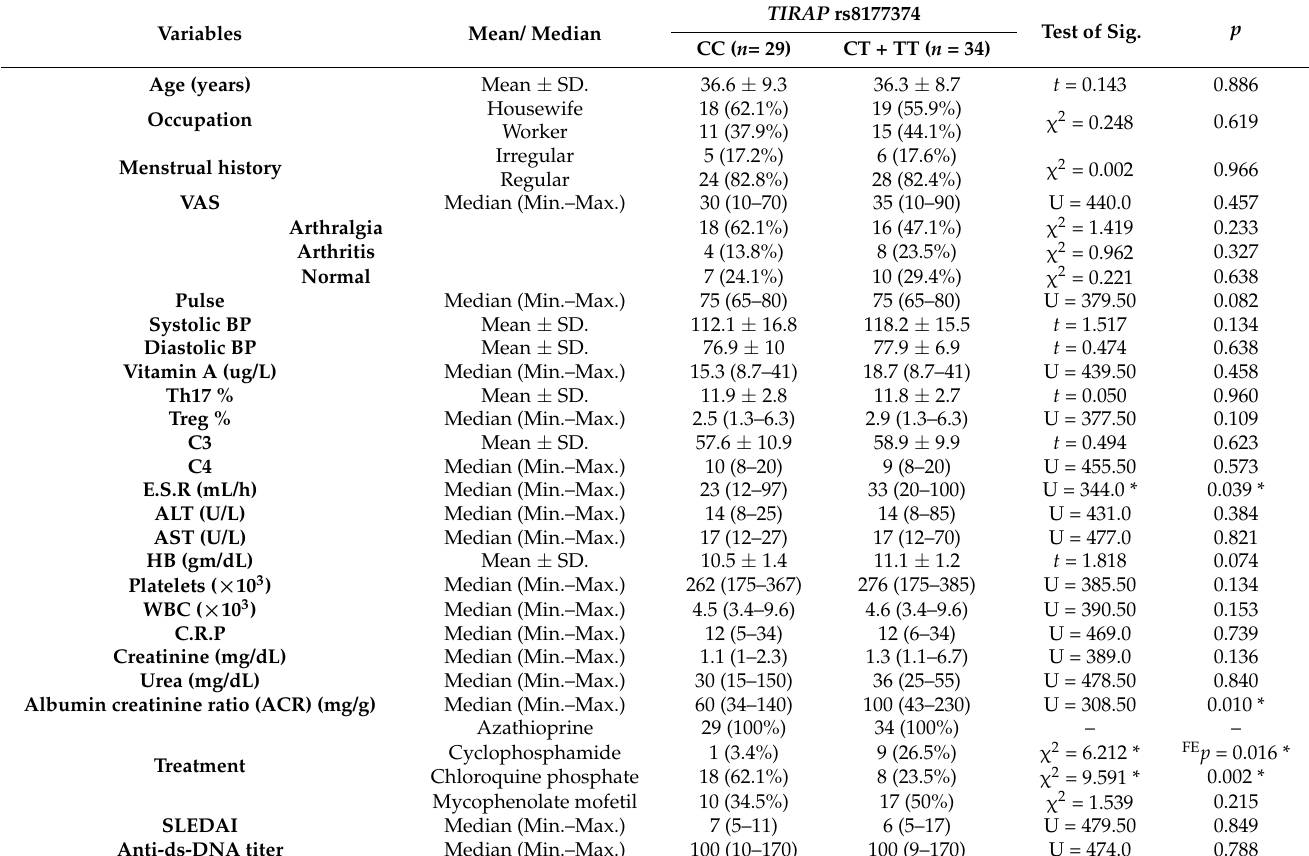
Table 6. Relationships between TIRAP rs8177374 genotypes and different parameters in patients with nephritis ( n = 63). Variables Mean/